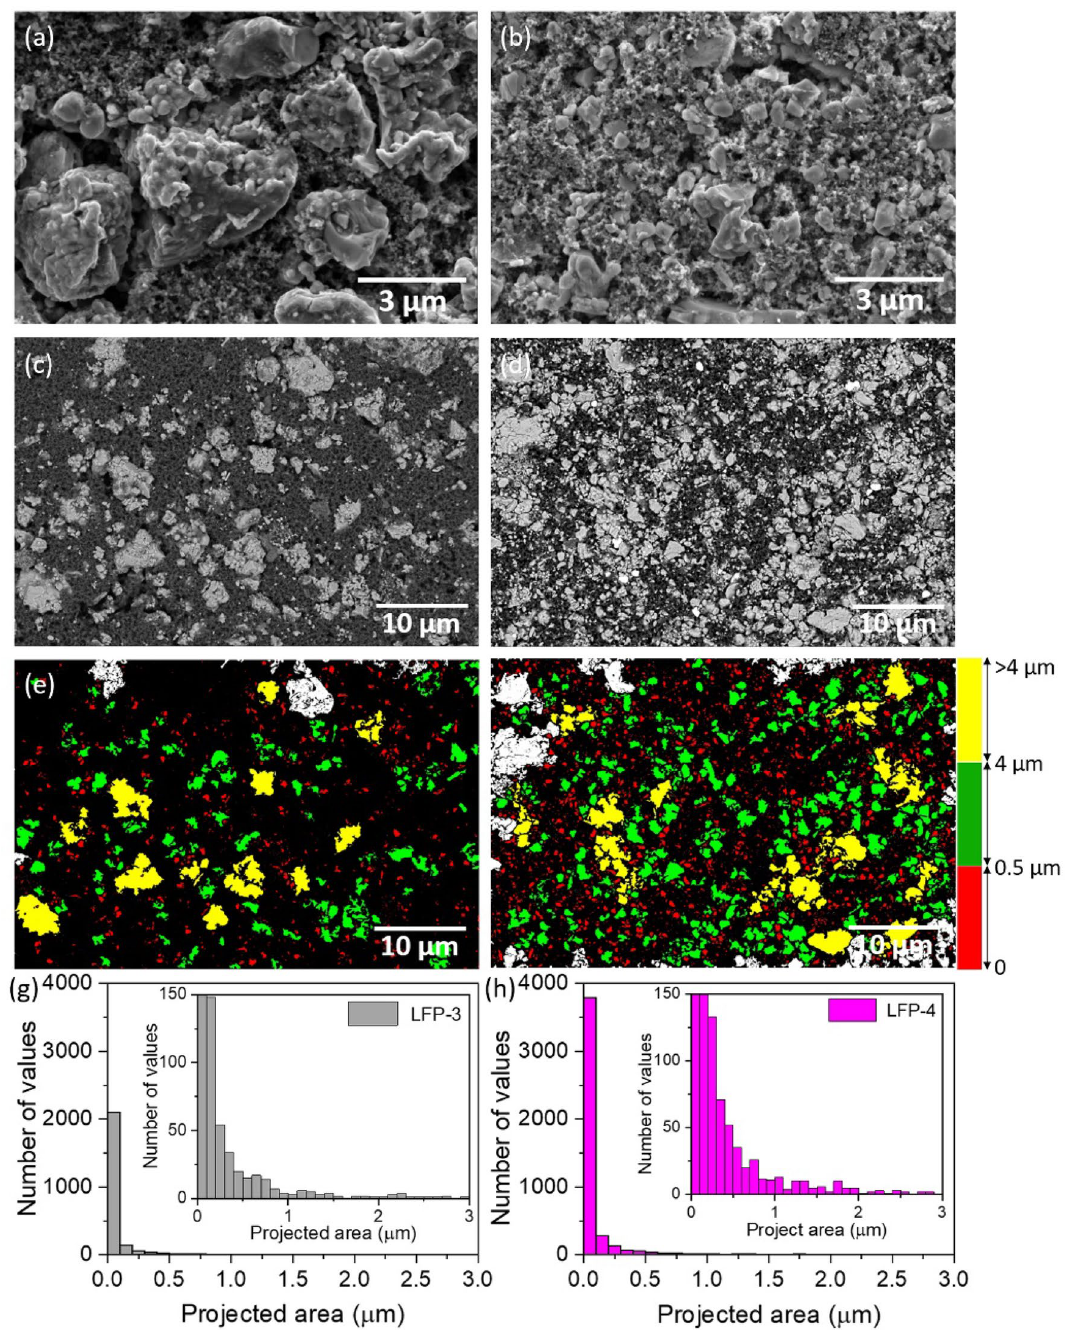
Figure 4. ( a ) and ( b ) are the SEM images of calendered LFP-3 and LFP-4 cathodes prepared by using magnetic stirring and ball milling processes, ( c ) and ( d ) are the SEM back scattered images, ( e ) and ( f ) are the particle size distribution with color codes defining the sizes and ( g ) and ( h ) are the corresponding projected area analysis of LFP-3 and LFP-4 cathodes indicating the number of LFP-4 sample and the increased number of particles in the projected area as given in Fig. 4h (number of values represents the number of particles in y axis) are obvious in LFP-4 in comparison to LFP-3 (Fig. 4g) indicating a preferential distribution of particle size ranging from nano to micron scale (≤ 4 μm) in LFP-4. This directly influences the electrochemical performance as shown in the Fig. 5a. The Li/SPNE/LFP-4 cell delivered high initial discharge capacity of 137 mAh g -1 , in comparison to Li/SPNE/LFP-3 cell (115 mAh g -1 ) at 1C rate at 70 °C. The enhanced electrochemical performance of Li/SPNE/LFP-4 cell could be attributed to the smaller LFP particles which increases the Li ion diffusion as well as electron percolation pathways more efficiently at high current rate. The influence of cathode particle size on the electrochemical performance of SS-LMB has been recently studied by Strauss et al. 20 , and reported that the ionic conductivity is not affected by the particle size, but the